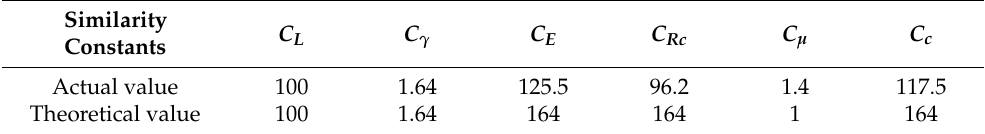
Table 2. The similarity constants of the